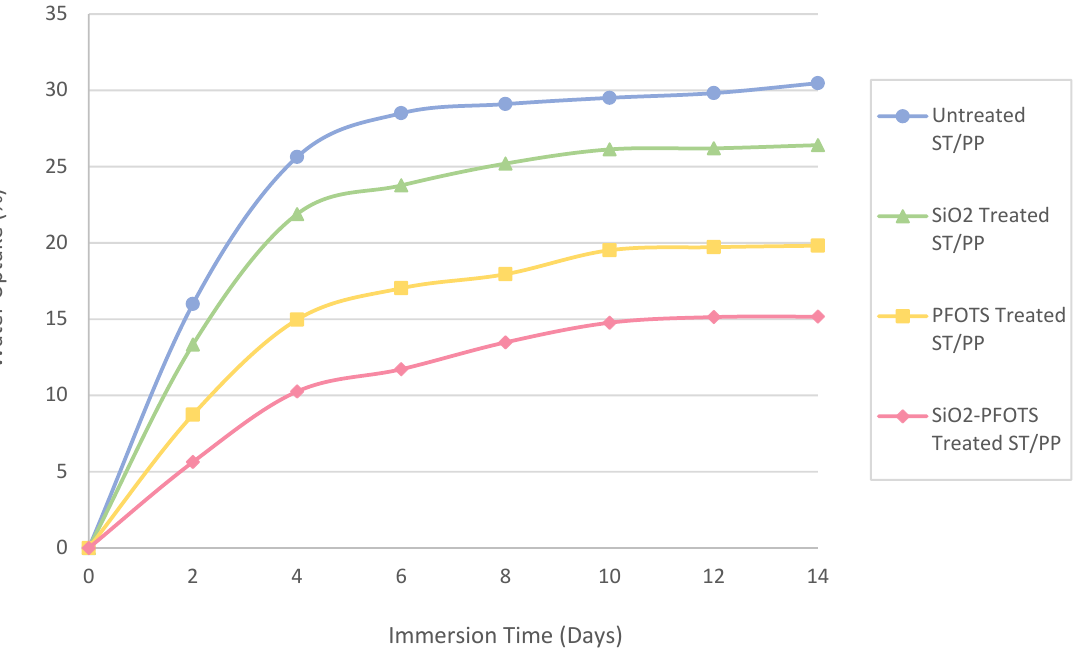
Figure 10. The water absorption rate of untreated ST/PP, SiO 2 treated ST/PP, PFOTS treated ST/PP, and SiO 2 -PFOTS treated ST/PP.